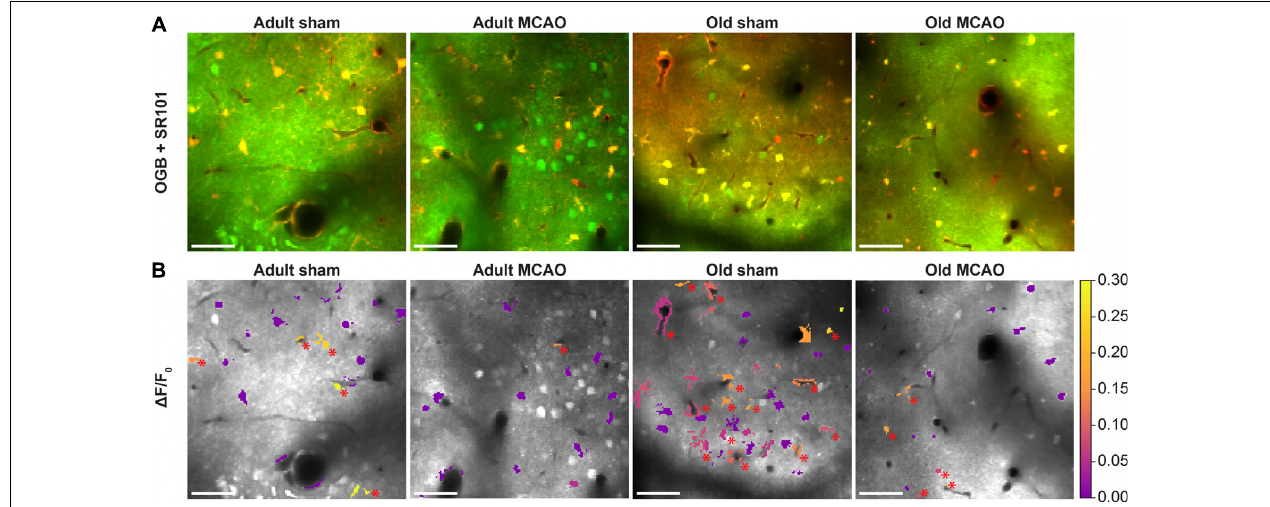
FIGURE 4 | Stroke reduced evoked Ca 2 + signals in astrocytic somas, processes, and end-feet. (A,B) Representative two-photon images recorded in adult and old mice after sham operation or permanent middle cerebral artery occlusion (MCAO). (A) Green indicates Oregon Green 488 BAPTA-1/AM (OGB). Red indicates sulforhodamine 101 (SR101). (B) OGB is shown in gray. Mean (cid:49) F/F 0 during 2-Hz whisker stimulation for 15 s is color-coded for astrocytic somas (a.s.), astrocytic processes (a.p.), and astrocytic end-feet (a.e.-f.). Red asterisk ( ∗ ) indicates responsive regions of interest. Scale bar = 50 µ m.